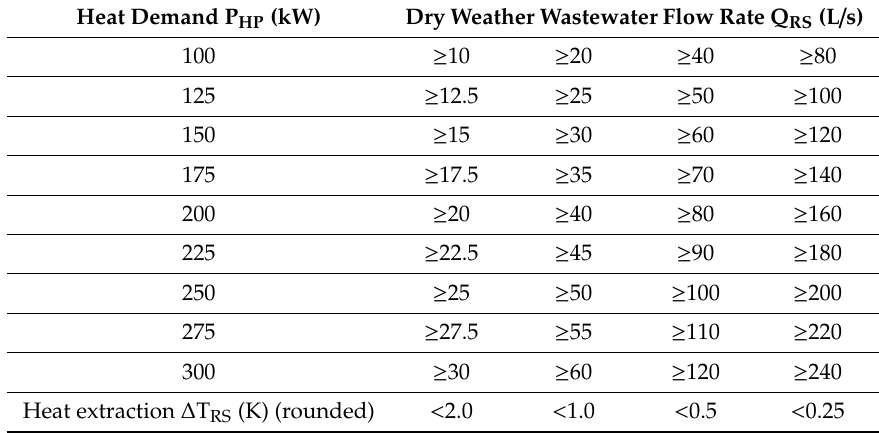
Table 2 di ff erentiates (arithmetic values of) wastewater heat-extraction levels in four ranges ( < 2.0, < 1.0, < 0.5 and < 0.25 K) depending on di ff erent heat demands and dry weather wastewater flows. Table 2. Wastewater flow rate criteria (own representation, based on